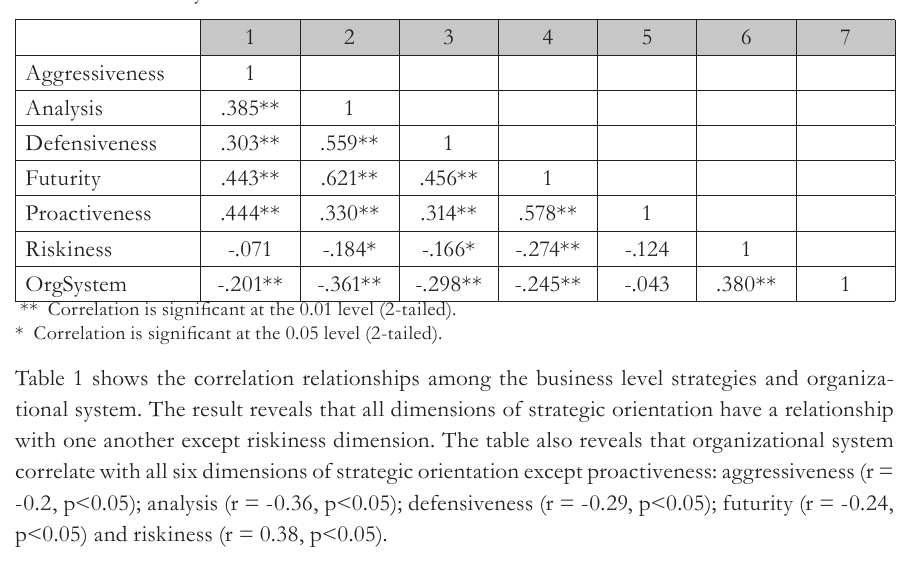
Tab. 1 - Zero-Order Correlation Co-efficient of Organizational System on Strategic Orientation. Source: Field